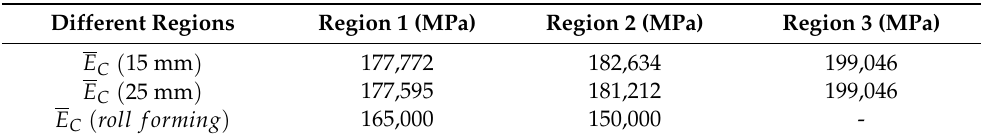
Figure 12. Three-point bending test results.